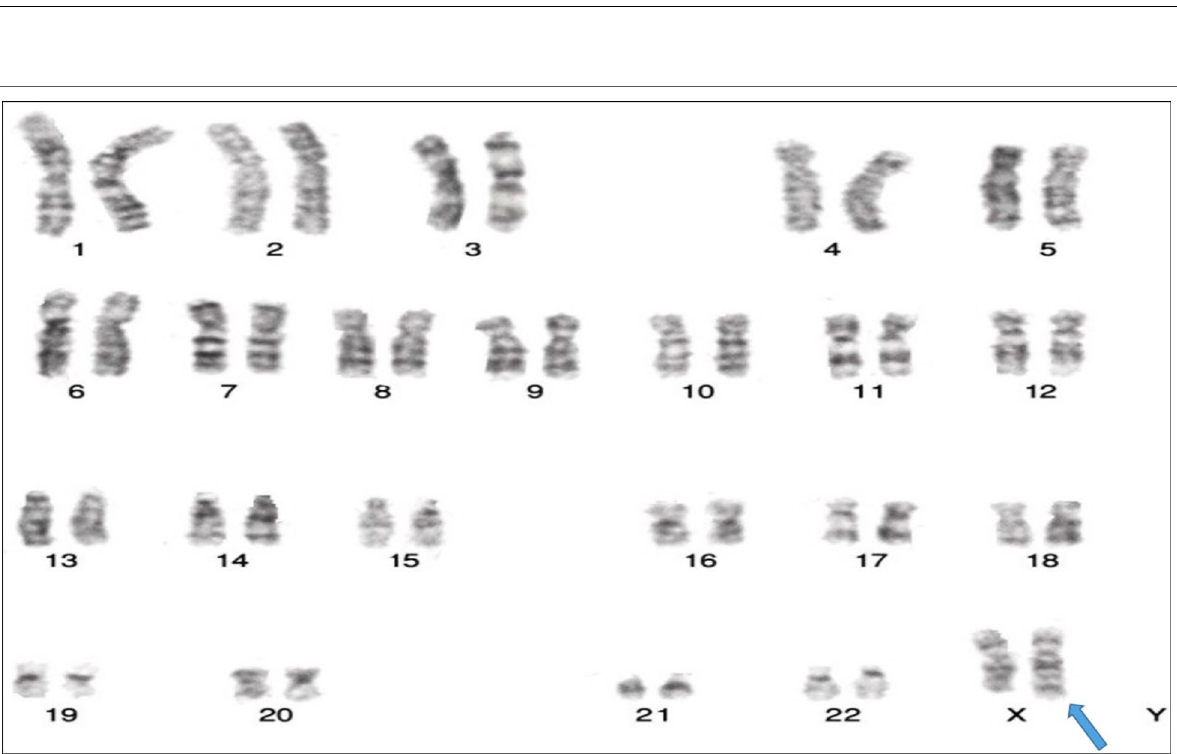
Fig. 3 Female karyotype with additional material of unknown origin attached to band Xq28